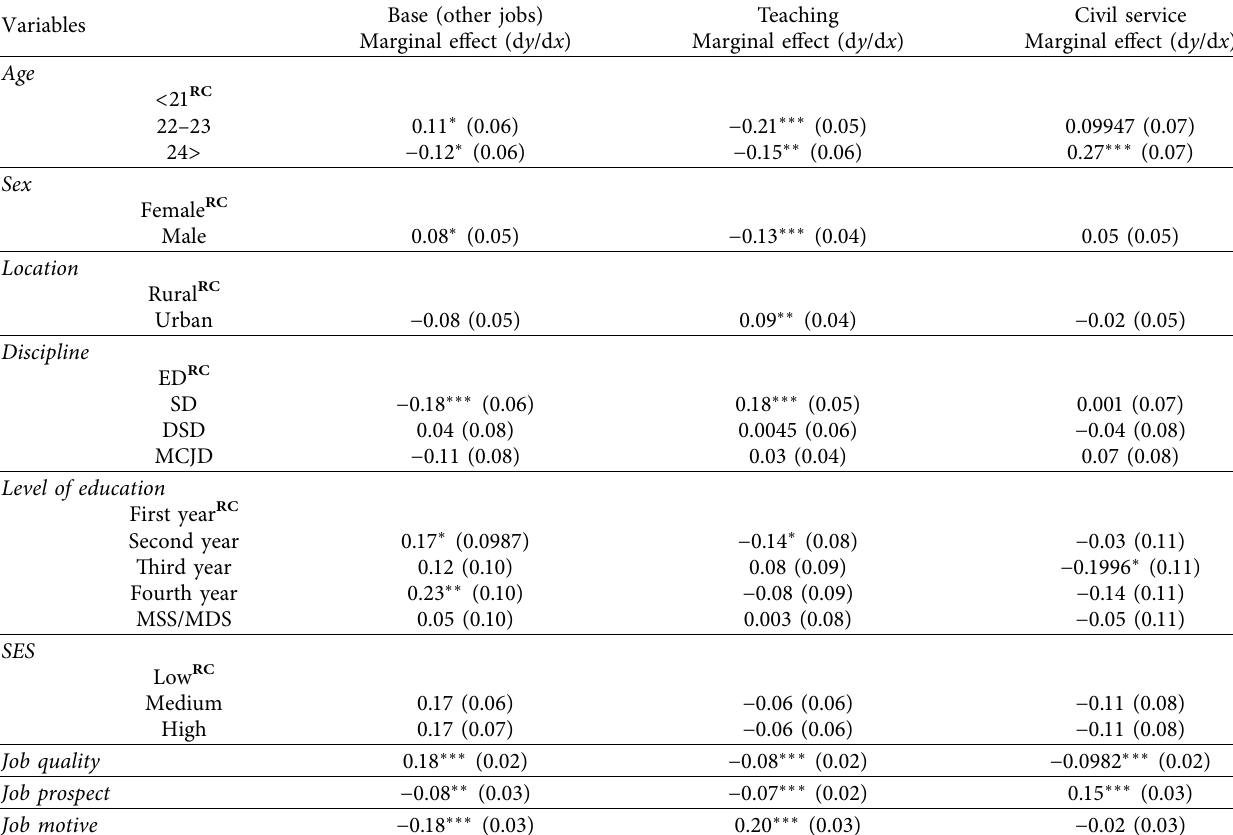
Table 5: Marginal effect of the multinomial logit